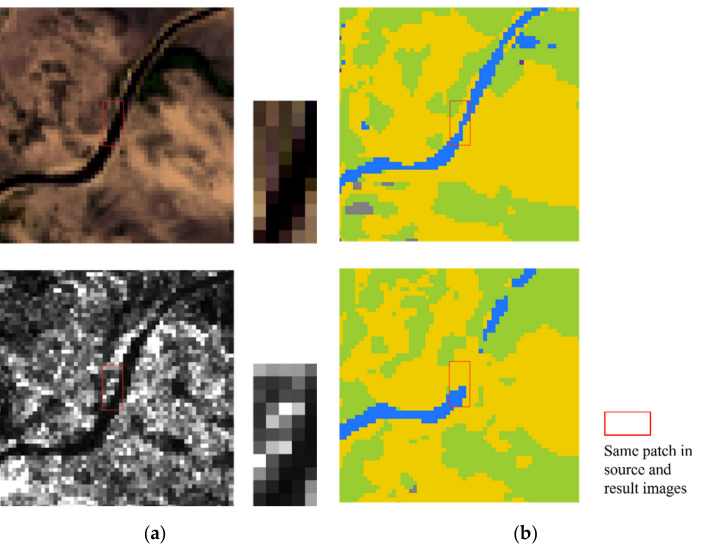
Figure 16. ( a ) Patches of size 5 × 11 extracted from the same sample point (same geographic location). ( Top : MS image; bottom : SAR image; right : zoomed-in view of the patch). ( b ) Classification result of the example region. ( Top : results using single-size patches with SK-like method; bottom : results using multi-size patches with SK-like